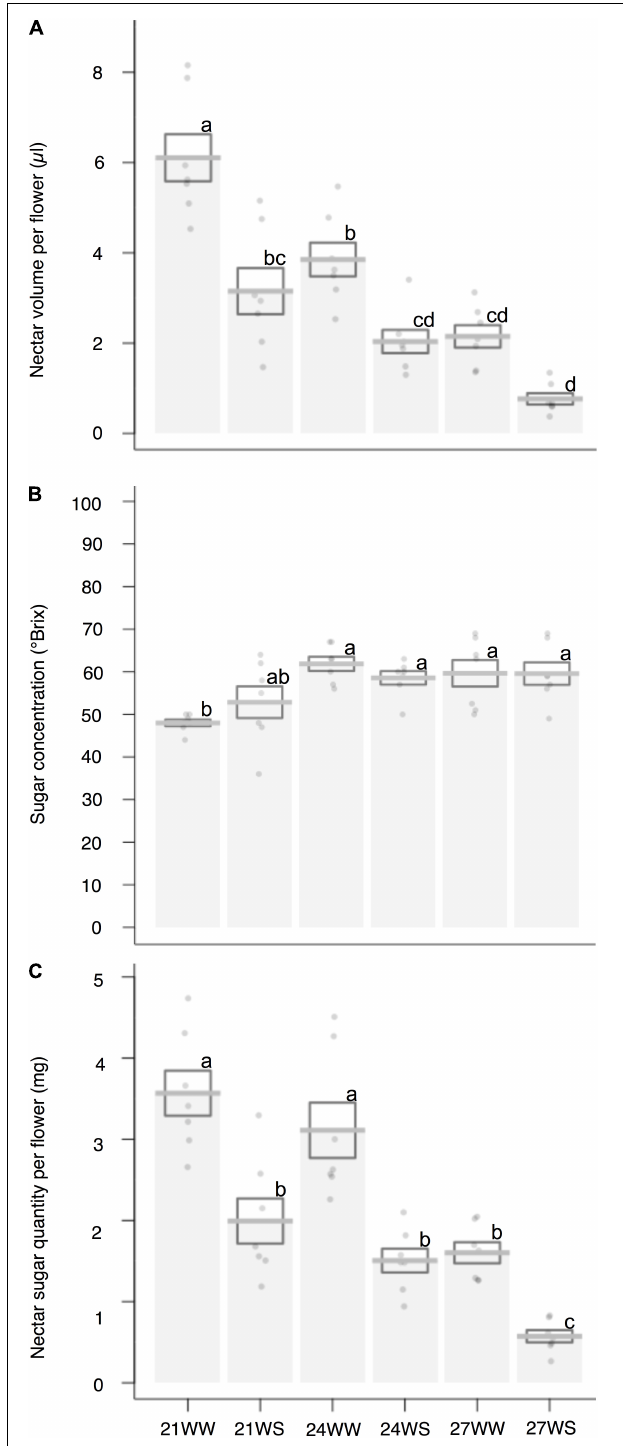
FIGURE 2 | Effects of temperature and water stress on nectar of B . officinalis , 3 weeks after stress induction: (A) nectar volume per flower ( µ l); (B) nectar sugar concentration ( ◦ Brix); (C) nectar sugar quantity per flower (mg). N = 7 plants. Data are means ± SE. Data points followed by different letters for the same parameter are significantly different at P < 0.05 among treatments. 21, 21 ◦ C; 24, 24 ◦ C; and 27, 27 ◦ C; WW, well-watered; WS,